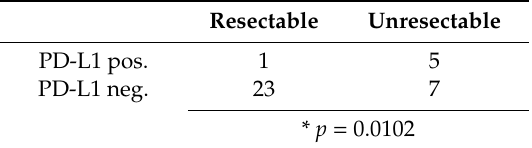
Table 6. Contingency table of the absolute number of patients with the features PD-L1 status and